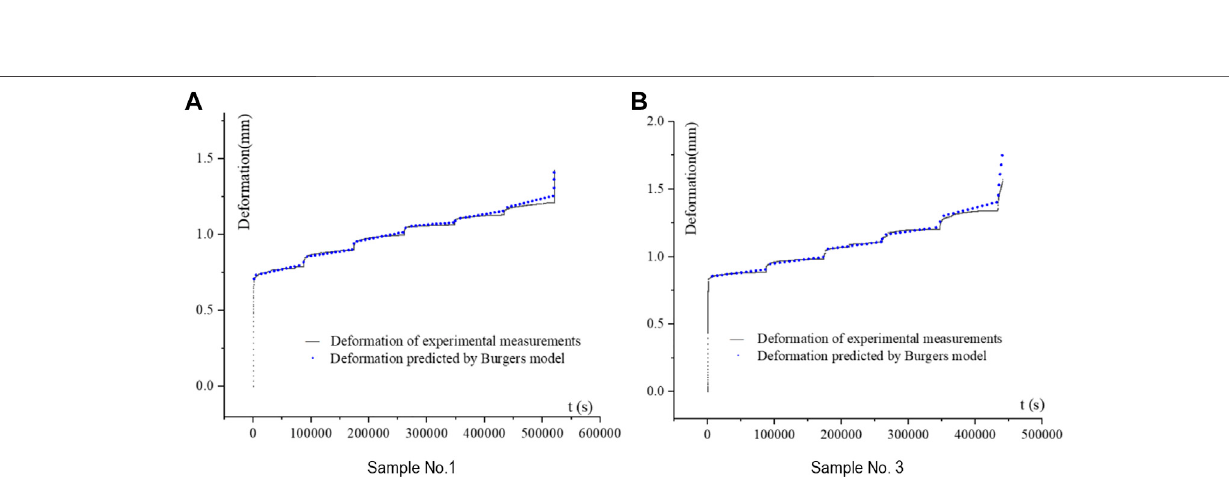
Frontiers in Earth Science |